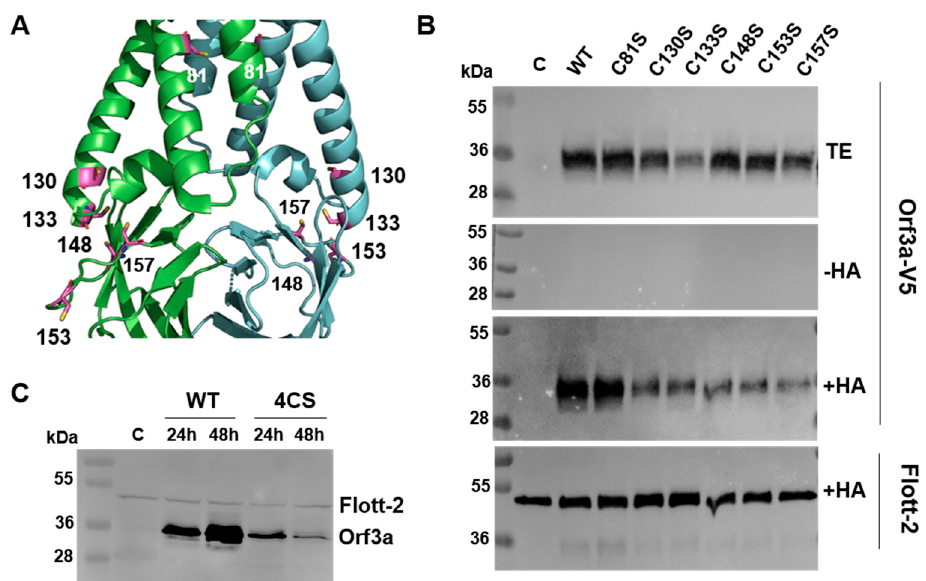
Figure 10. Orf3a of SARS-CoV-2 is palmitoylated at membrane-near cysteine regions in the cyto- plasmic tail. ( A ) Cartoon structure of Orf3a with cysteine residues highlighted as magenta sticks. ( B ) Acylation analysis of wt and mutant Orf3a protein. Upper panel: The Orf3a gene (wt and the mutants), where individual cysteines were substituted by serines and were fused at the C-terminus to a V5 tag and expressed in 293T cells. To test for protein expression, 10% of the cell lysate was removed. Middle and lower panel: The remainder of the lysate was divided into two aliquots, one not treated ( − HA) and one treated with hydroxylamine (+HA) to cleave cysteine-bound fatty acids before pulling down proteins with a free SH group. Samples were subjected to Western blotting with antibodies against the V5 tag and, subsequently, with those against the endogenous protein flotillin-2 (Flot-2). Molecular weight markers are shown on the left of each blot. ( C ) Stability analysis of Orf3a. Wt Orf3a and a mutant, where the four acylated cysteines 130, 133, 148 and 153 were exchanged to serine, were expressed in 293T cells, which were lysed 24 or 48 h after transfection. Identical aliquots of the cell lysate were subjected to Western blotting with antibodies against the V5 tag and, subsequently, with those against the endogenous protein flotillin-2 (Flott-2) as the loading control. C: untransfected control cells.